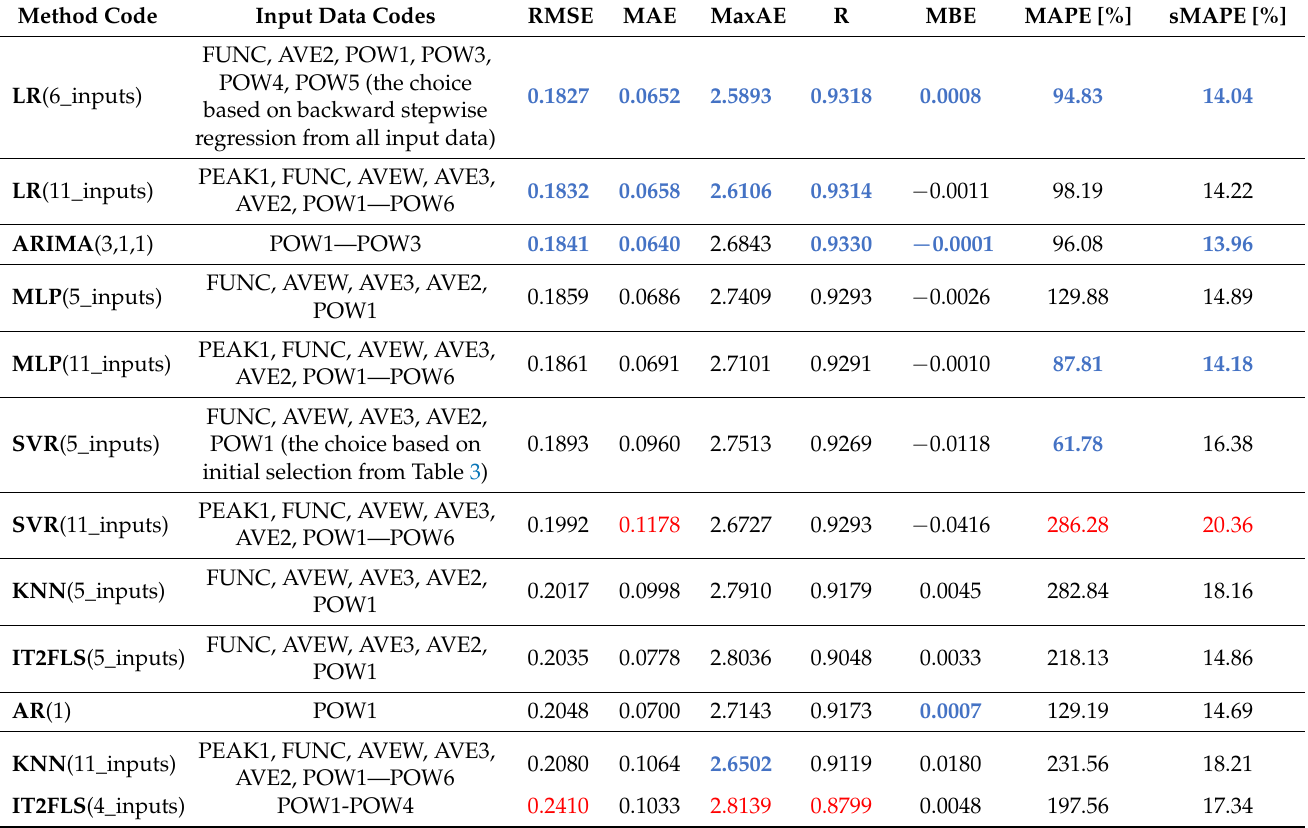
Table 8. Performance measures of proposed single methods (on test subset range) for time series No. 2. Method